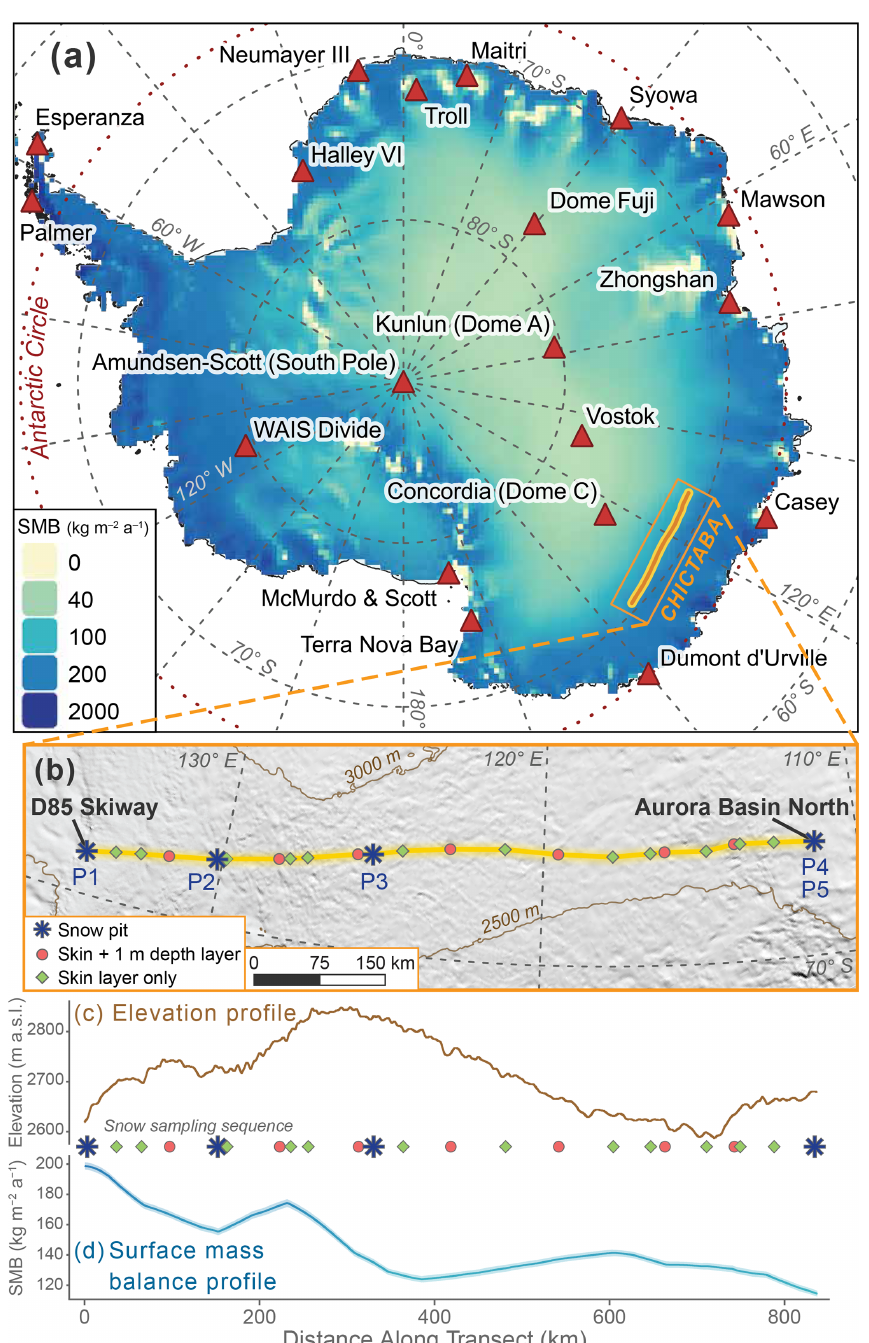
Figure 2. Maps and environmental profiles of the CHICTABA traverse. (a) Spatial variability in surface mass balance (SMB) across Antarc- tica shown by base color shading of MARv3.12.1 output data for the years 2011–2013 (Agosta et al., 2019; Amory et al., 2021). Major Antarctic stations are labeled (COMNAP, 2017), and the route of the CHICTABA transect is indicated by the orange and yellow line. (b) Zoomed map focused on the CHICTABA route (yellow line) overlaid on hillshaded topography with elevation contours shown in brown (Howat et al., 2019). Snow sampling locations along the transect and the sampling method are shown by colored icons with snow pit sites labeled. (c) Elevation (Howat et al., 2019) and (d) SMB (Agosta et al., 2019; Amory et al., 2021) profiles along CHICTABA starting from the D85 skiway and ending at Aurora Basin North, following the layout of (b) , with the sequence of snow sampling sites along the transect provided. The resolution of the elevation profile reflects the 200m REMA raster cell size. The SMB values for the SMB profile were bilin- early interpolated at 1km intervals from the original 35km MAR output grid. MAR SMB uncertainty is included on (d) as a shaded zone around the profile line but is difficult to see due to its small